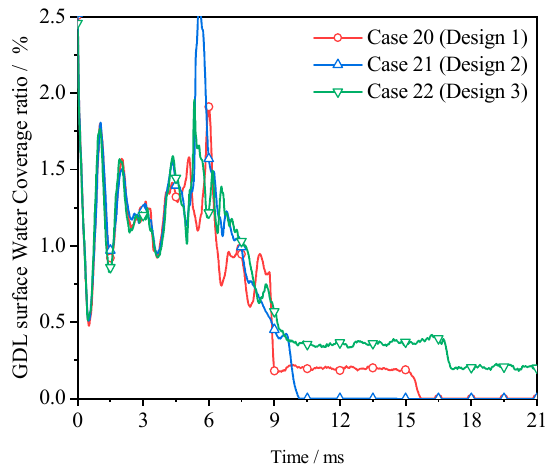
Figure 12. GDL surface water coverage ratio at an inlet velocity of 12.5 ms − 1 and contact angles θ GDL = 120°, θ side; top = 82°; 45°, respectively.